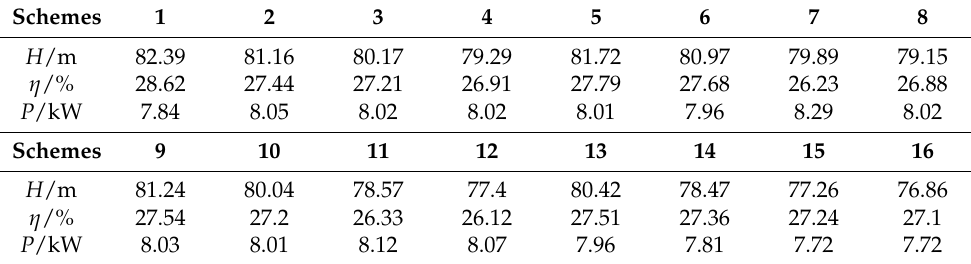
Table 4. Numerical simulation results at 1.0 Q des .